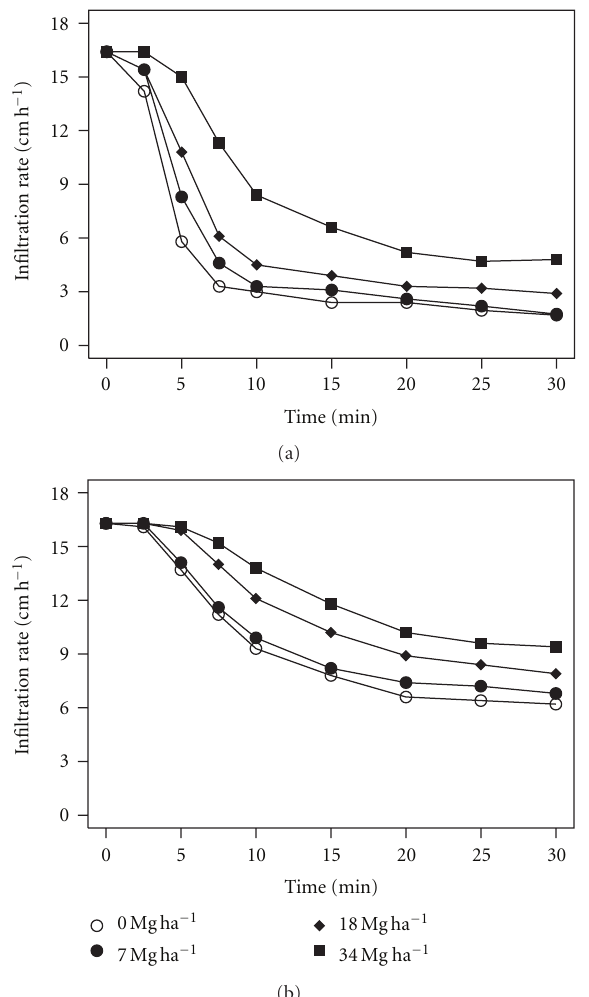
Figure 14: Infiltration rate (cmh − 1 ) during a 30-min simulated rainfall (164mmh − 1 ) on (a) bare or (b) vegetated Stellar soils as a ff ected by biosolids application (redrawn from [17]).